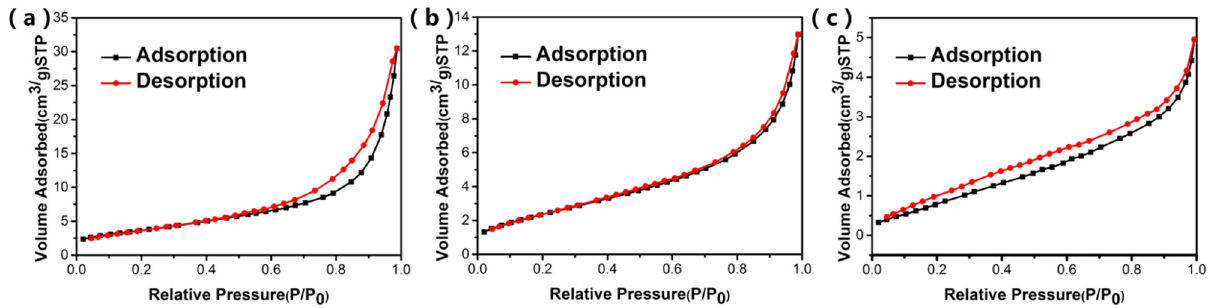
Figure 6: N 2 adsorption – desorption isotherm of ( a ) fl ower - like ZnO, ( b ) urchin - like ZnO, and ( c ) rod - like ZnO.